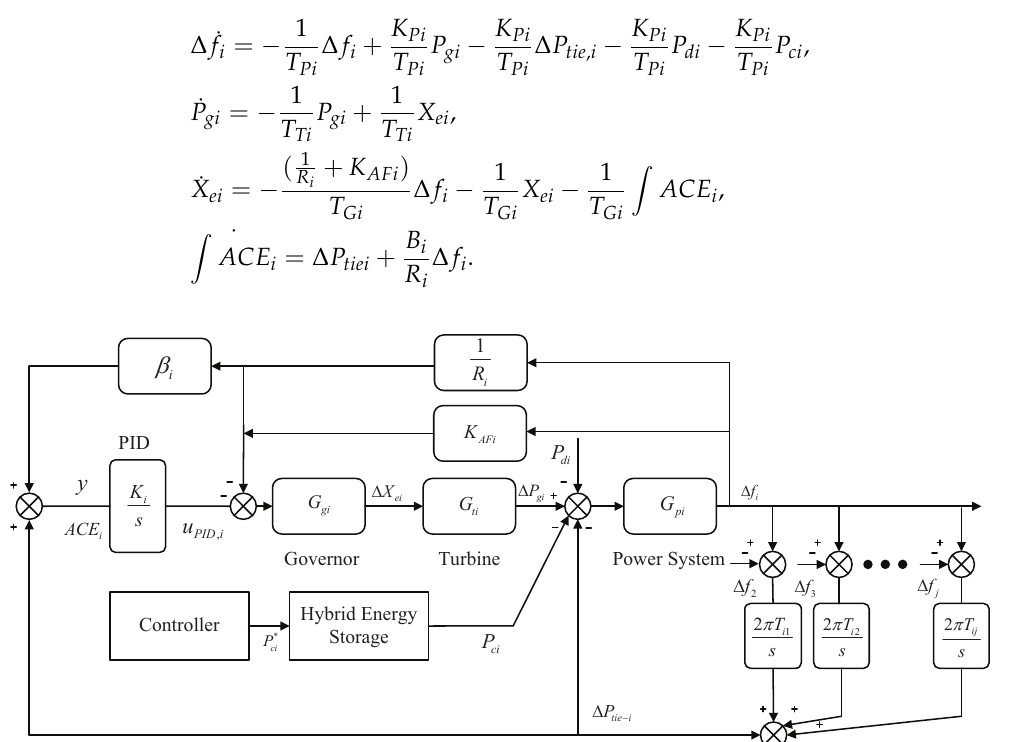
Figure 2. The transfer function model of the i -th area of the interconnected power system, where G gi represents the transfer function model of the governor, G ti represents the transfer function model of the steam turbine, and G pi represents the transfer function model of the